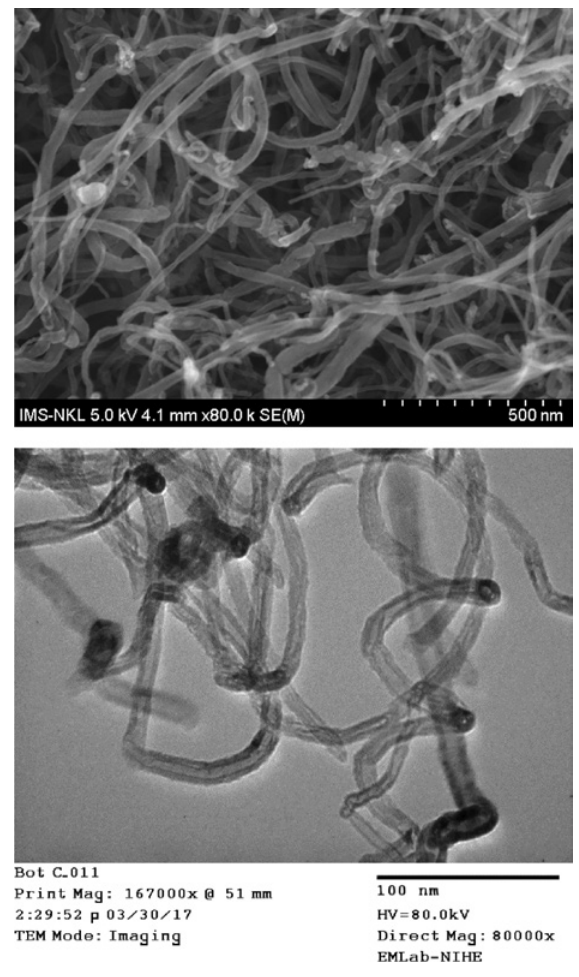
Figure 7: FE-SEM and STEM images of